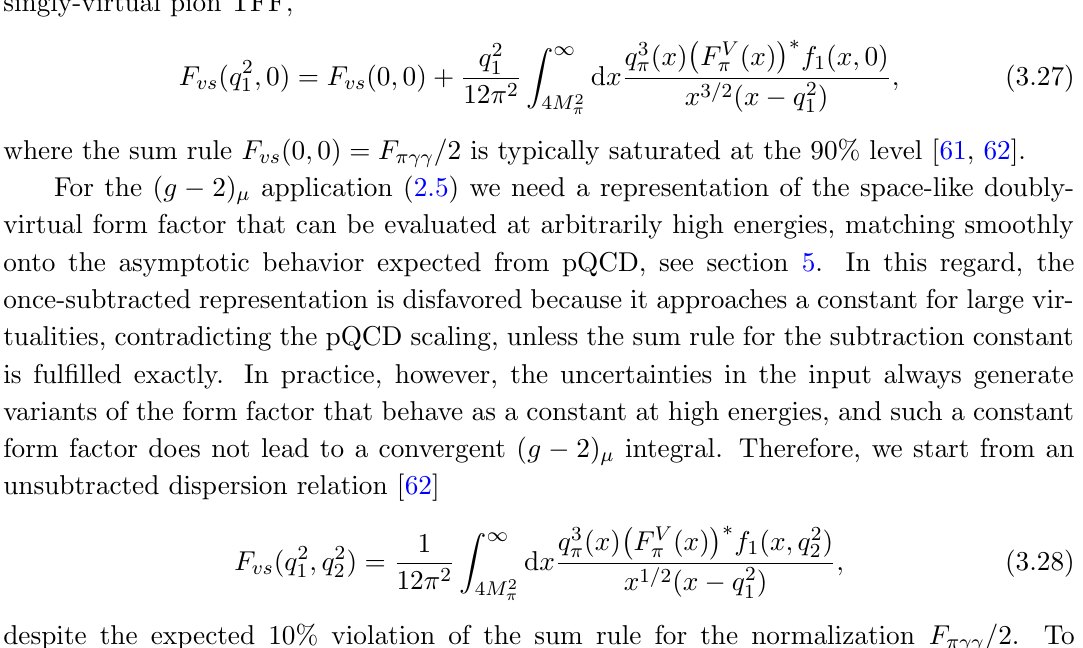
M 2 . For q 2 = M 2 , the representation (3.25) has been used (cid:25) 2 !=(cid:30) (cid:0)